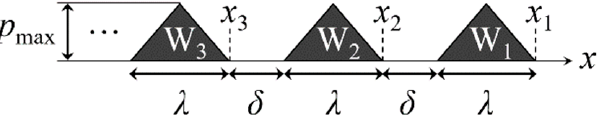
Figure 1. Wave profiles of atmospheric pressure waves traveling in the positive direction of the x -axis at the initial time, i.e., t = 0 s. The length and maximum pressure of the waves are denoted by λ and p max , respectively, and the interval between the waves is δ . The location of the onshore end of the n th wave W n is x n at t = 0 s.